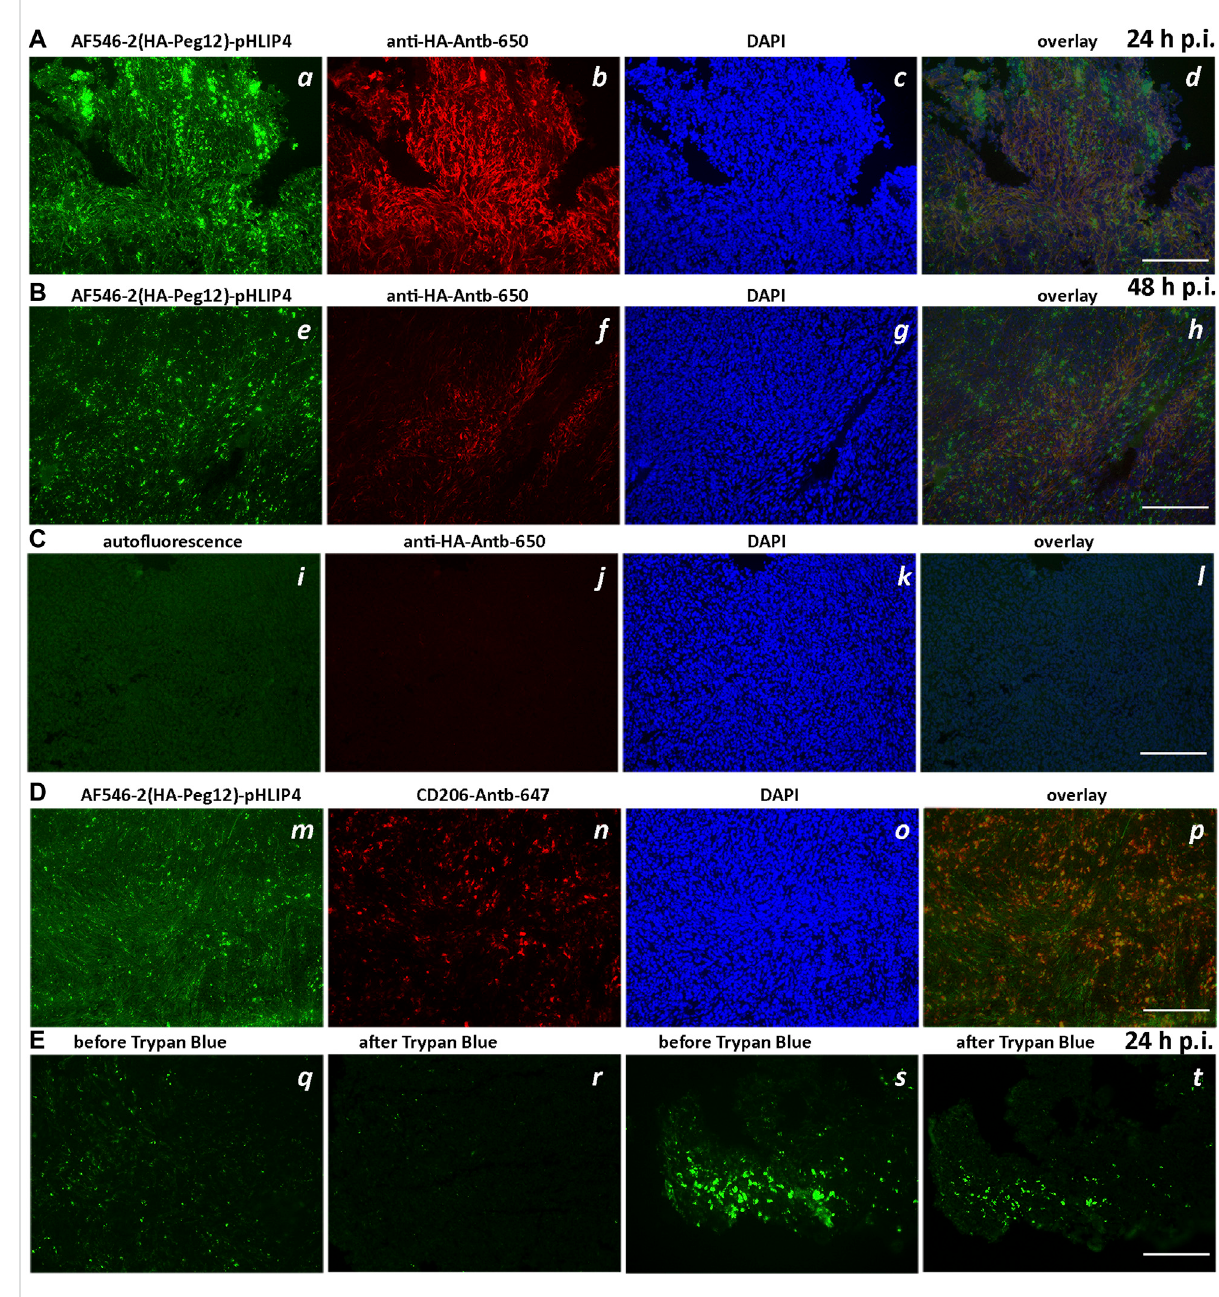
FIGURE 7 ExtracellularexposureofHAepitopeintumors.FluorescenceimagesoftumorsectionsobtainedfrommiceinjectedwithAF546-2(HA-Peg12)- pHLIP4 (40 μ M400 μ l) (A,B,D,E) and control mice, which didnot receiveinjectionofHA-pHLIPagent (C) . The fl uorescenceimagesofAF546-2(HA- Peg12)-pHLIP4(a,e,m), sections stained with anti-HA-Antb-650 (b,f,j),orCD206-Antb-647 (n)and DAPI(c,g,k,o),and overlay images (d,h,l,p)(image d is an overlay of 3 images a, b, and c; image h is an overlay of 3 images e, f, and g; and image l is an overlay of 3 images i, j, k, and image p is an overlay of 2 images m and n) are shown for tumors resected 24-h (A) and 48-h (B) after a single IP injection of AF546-2(HA-Peg12)-pHLIP4. (C) represents images of tumor sections obtained from control mice [no injection of HA-pHLIP agents (i)], while sections were stained with anti-HA- Antb-650 (j) and DAPI (k). In (E) , two sets of images from un fi xed tumor sections obtained from the mice injected with AF546-2(HA-Peg12)- pHLIP4 are shown before (q,s) and after (r,t) addition of solution of Trypan Blue to the sections. The images were acquired using a fl uorescence inverted microscope. 200- μ m scale bars are